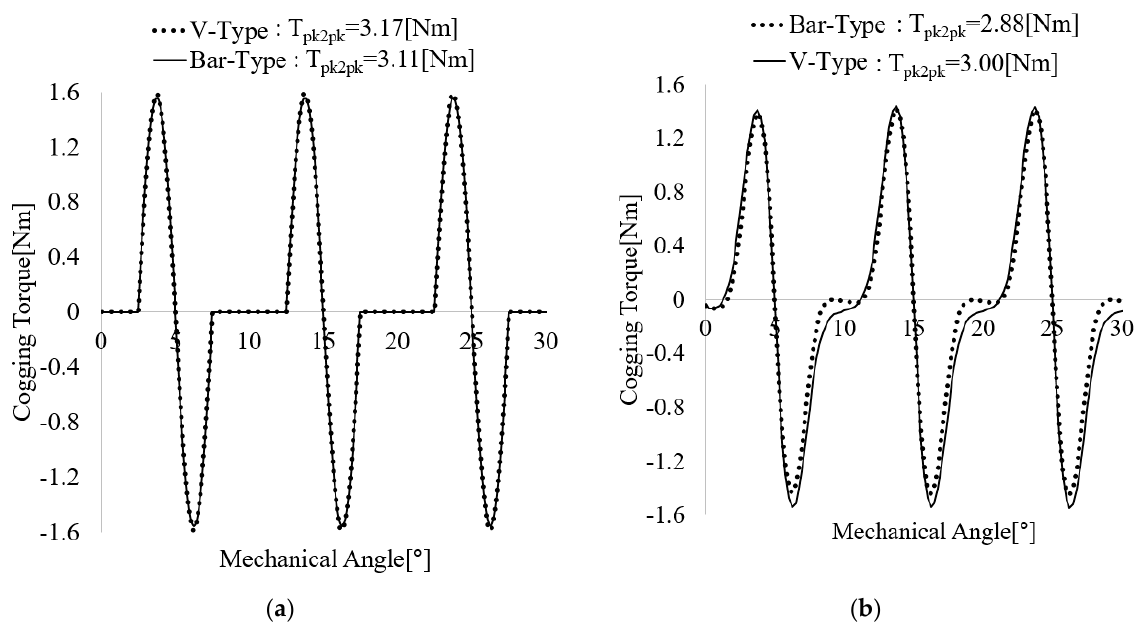
Figure 13. Comparison of flux density distribution of the air gap with bar-type and V-type rotors with slots: ( a ) HMEC, ( b ) FEM.